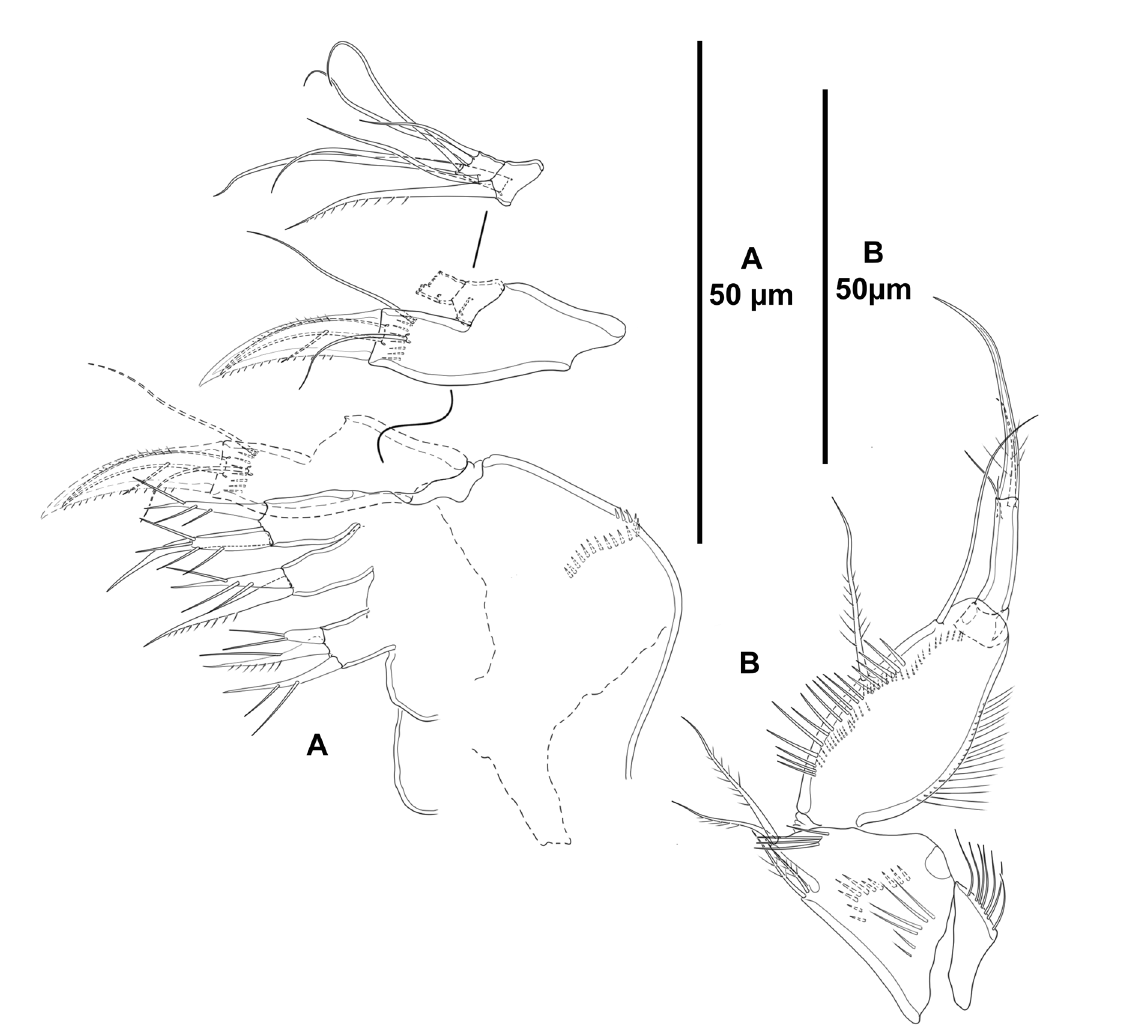
Fig. 5. Typhlamphiascus medici sp. nov., paratype, ♀ (ICML-EMUCOP-180119-41). A . Maxilla. B .